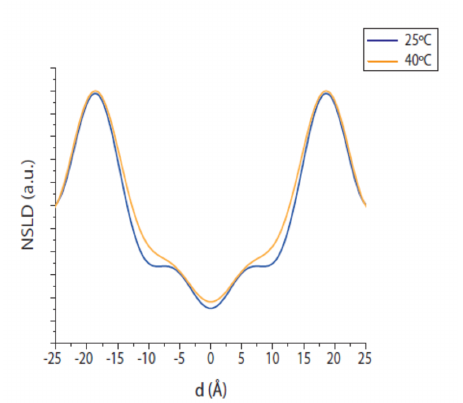
Figure 5. Neutron scattering length density as a function of temperature. Hydrated with 8% D 2 O. NSLD of DoPhPC:DoPhPE (9:1) obtained by neutron diffraction at 100% RH as a function of temperature: 25ᵒC (blue) and 40ᵒC (ochre). Table 2. Structural parameters from DoPhPC:DoPhPE (9:1) fully hydrated with 8% D 2 O obtained by neutron di ff raction as a function of temperature. In case of 55 ◦ C and 70 ◦ C, it was not possible to extract all parameters as the membranes were not su ffi ciently structured to yield enough Bragg